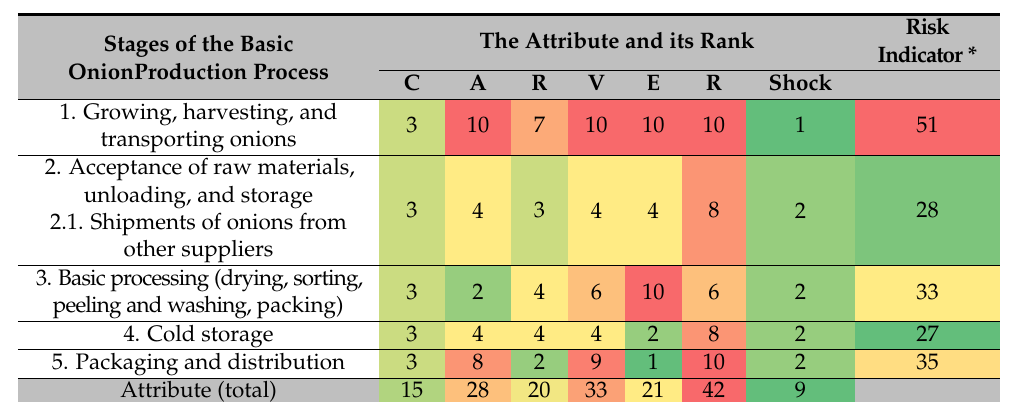
The Attribute and its Rank